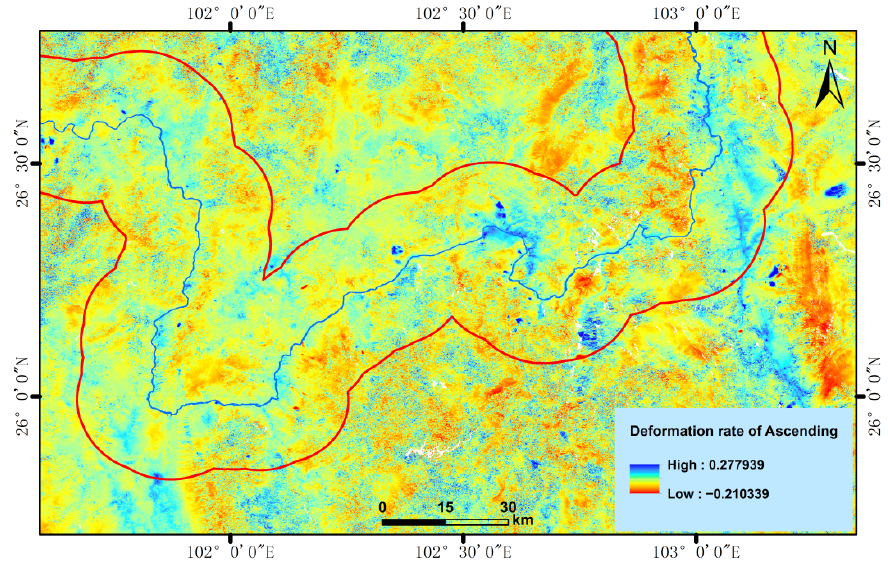
Figure 2. Deformation Results of the Ascending Orbit.